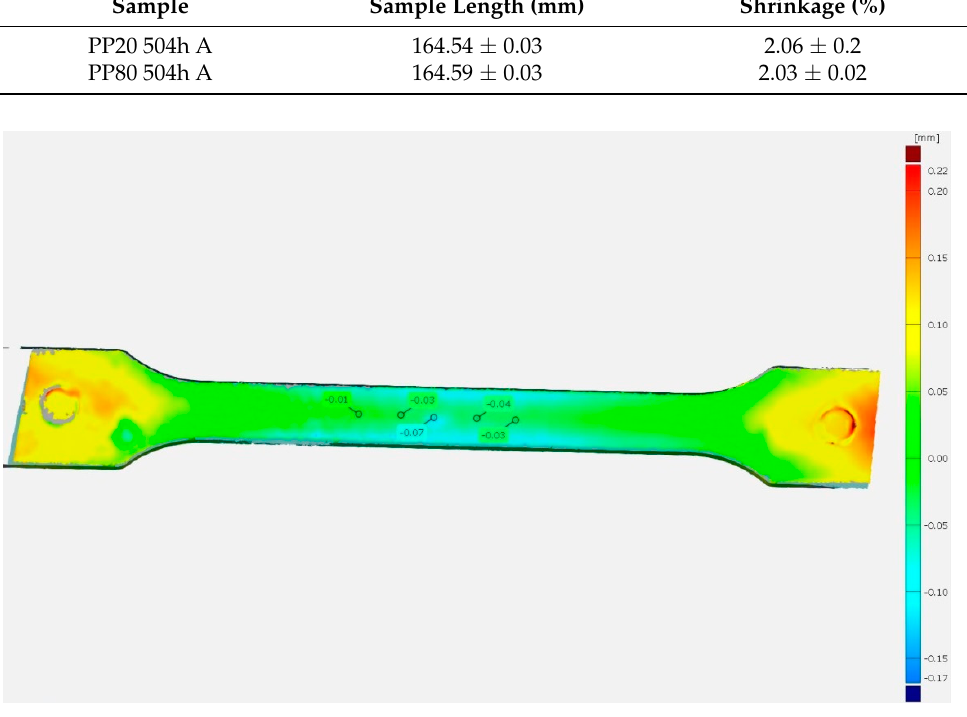
Table 1. Shrinkage values of annealed samples.